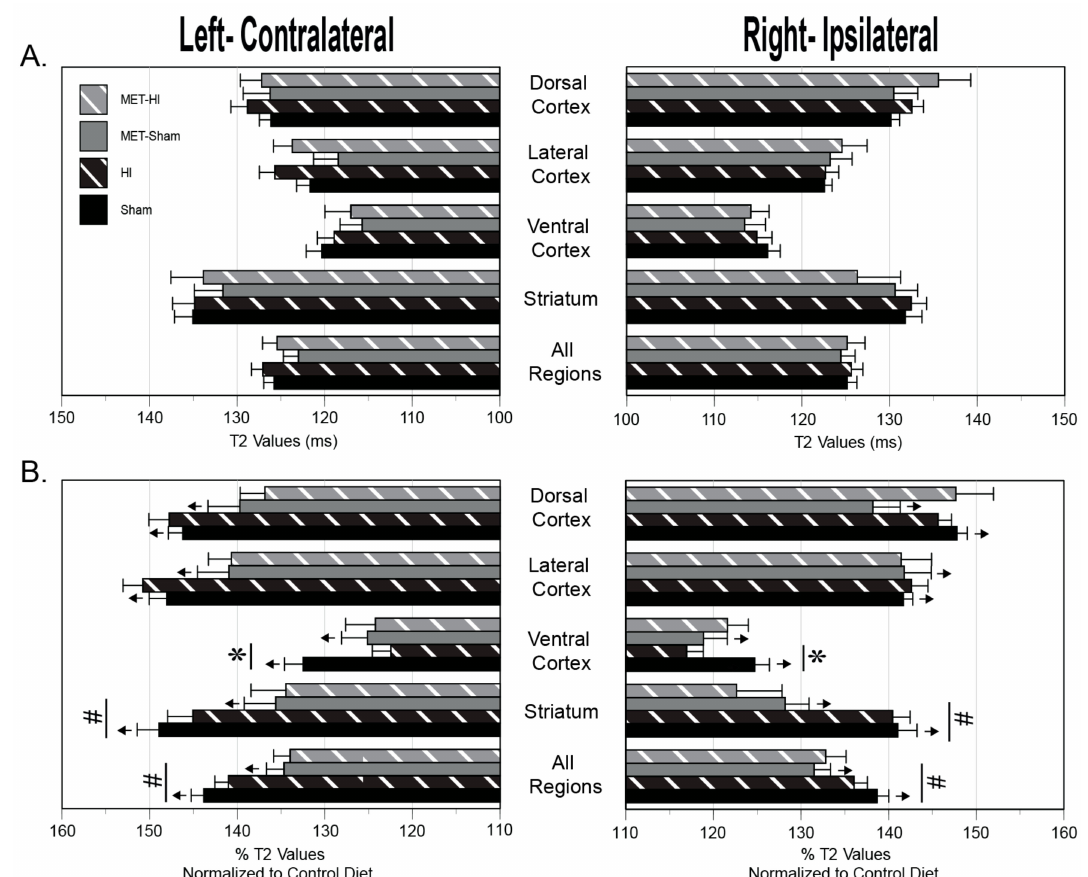
Figure 8. Effects of HI, gestational MET, and MUN on T2 values in P11/P12 pups. Regions of interest from four regions in each hemisphere are depicted above. The “All Regions” results represent hemispheric averages of the four regions combined. ( A ) Columns and error bars indicate SEM and show difference between MUN groups. ( B ) Columns and error bars indicate MUN values normalized to CD for each response and show MUN-induced effects. ANOVA with a post-hoc Fisher’s LSD determined the statistical significance as shown by: * for differences between Sham and HI groups and # for differences between MET-Sham and Untreated-Sham groups. Refer to Figure 4 for a description of the statistical symbols shown above. n = 12 in all groups except MET-Sham where n =